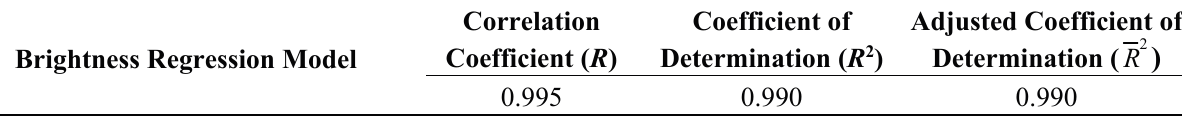
Table 4. Brightness regression model summary.